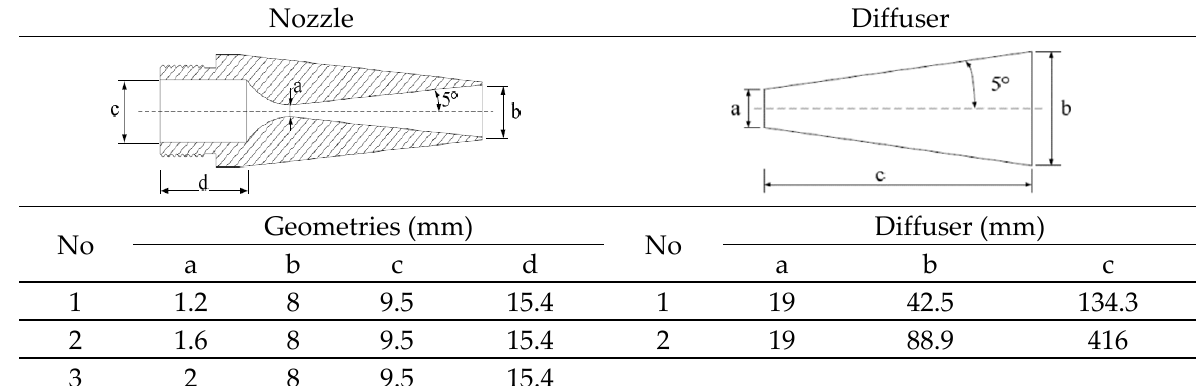
Figure 12. Geometry considered for this study [65].